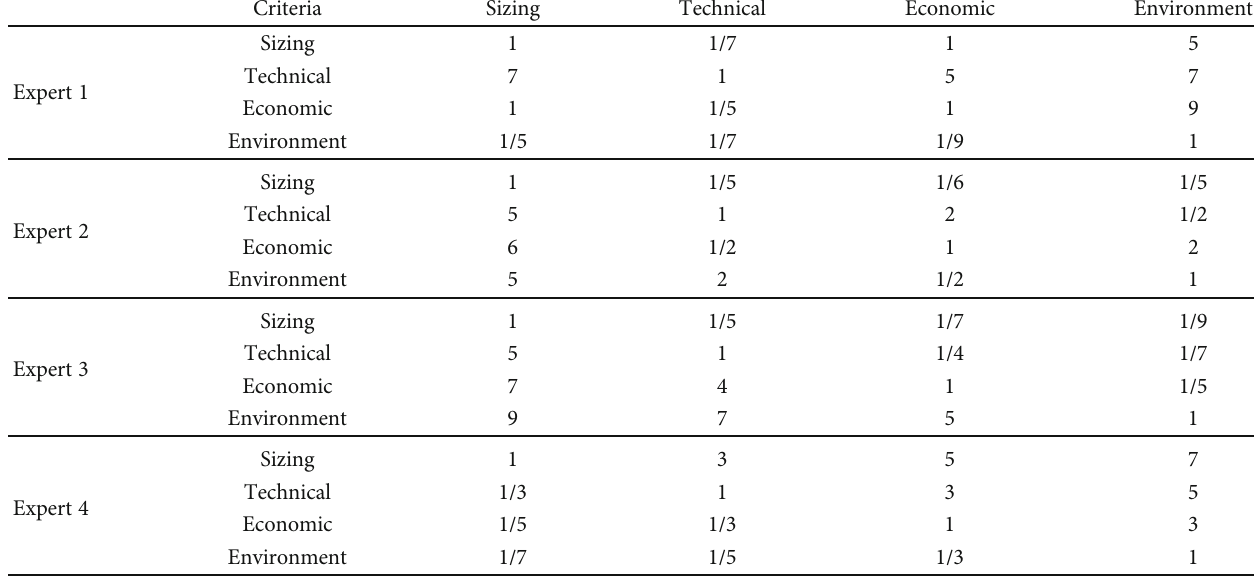
Table 7: Comparison of criteria in a numerical scale of experts.